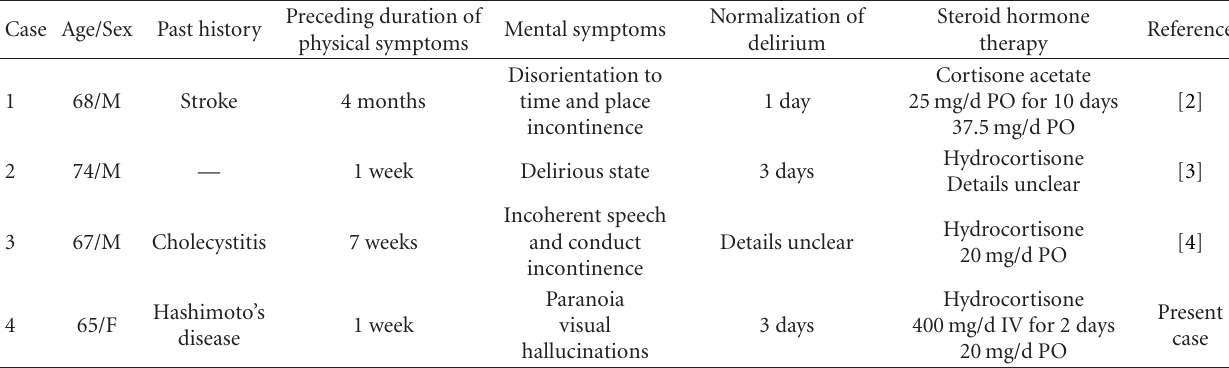
Table 3: Reported cases with isolated ACTH deficiency with